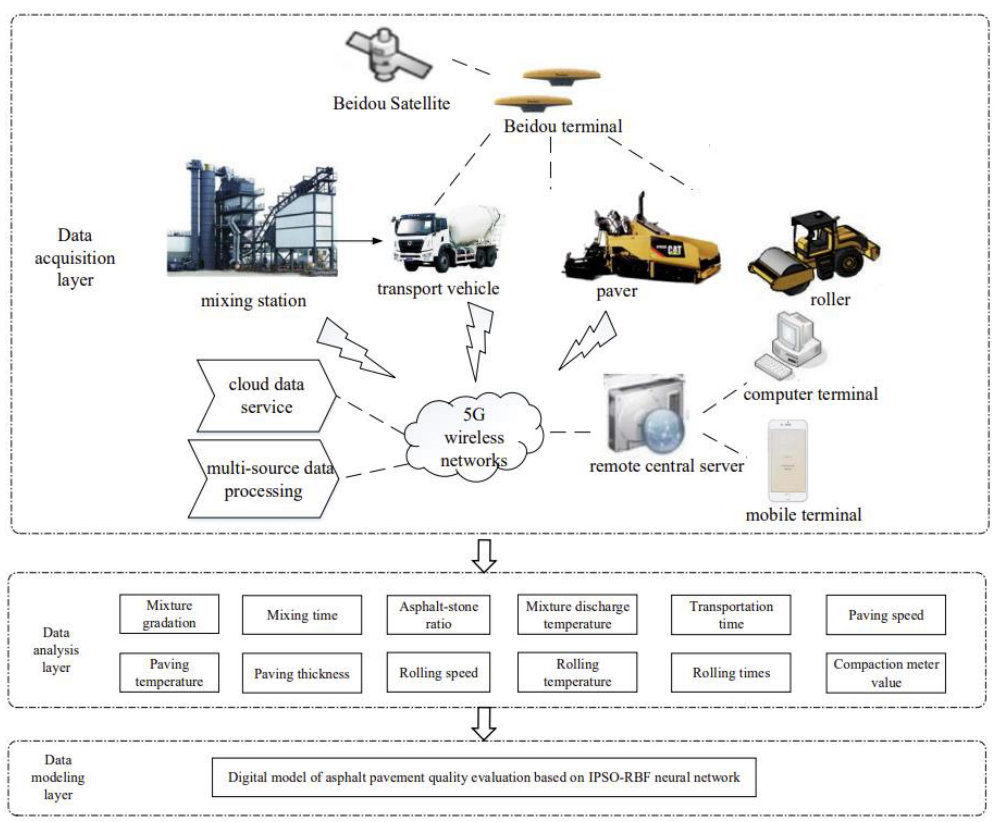
Figure 2. Structure diagram of digital monitoring system for measuring asphalt pavement construc- tion quality [5].